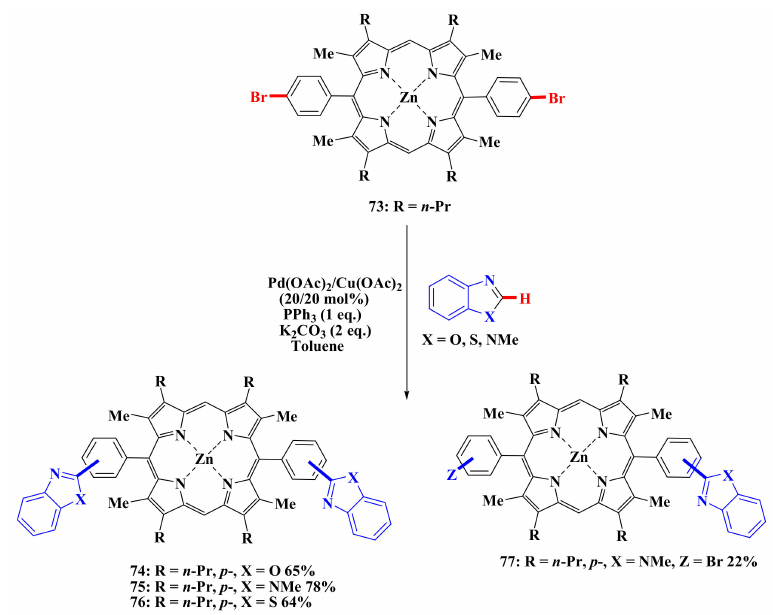
Scheme 14. Scheme of porphyrins modification by